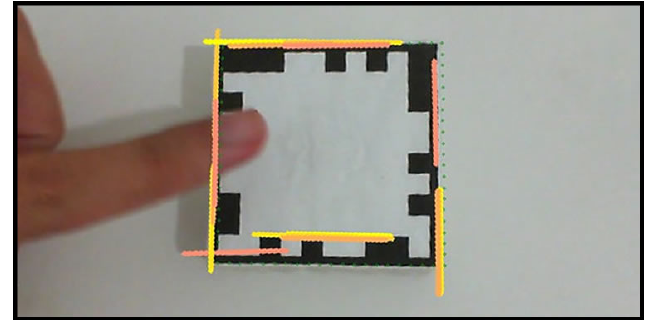
Fig. 7. Every colored line represents different hypotheses for the markers’ edges.